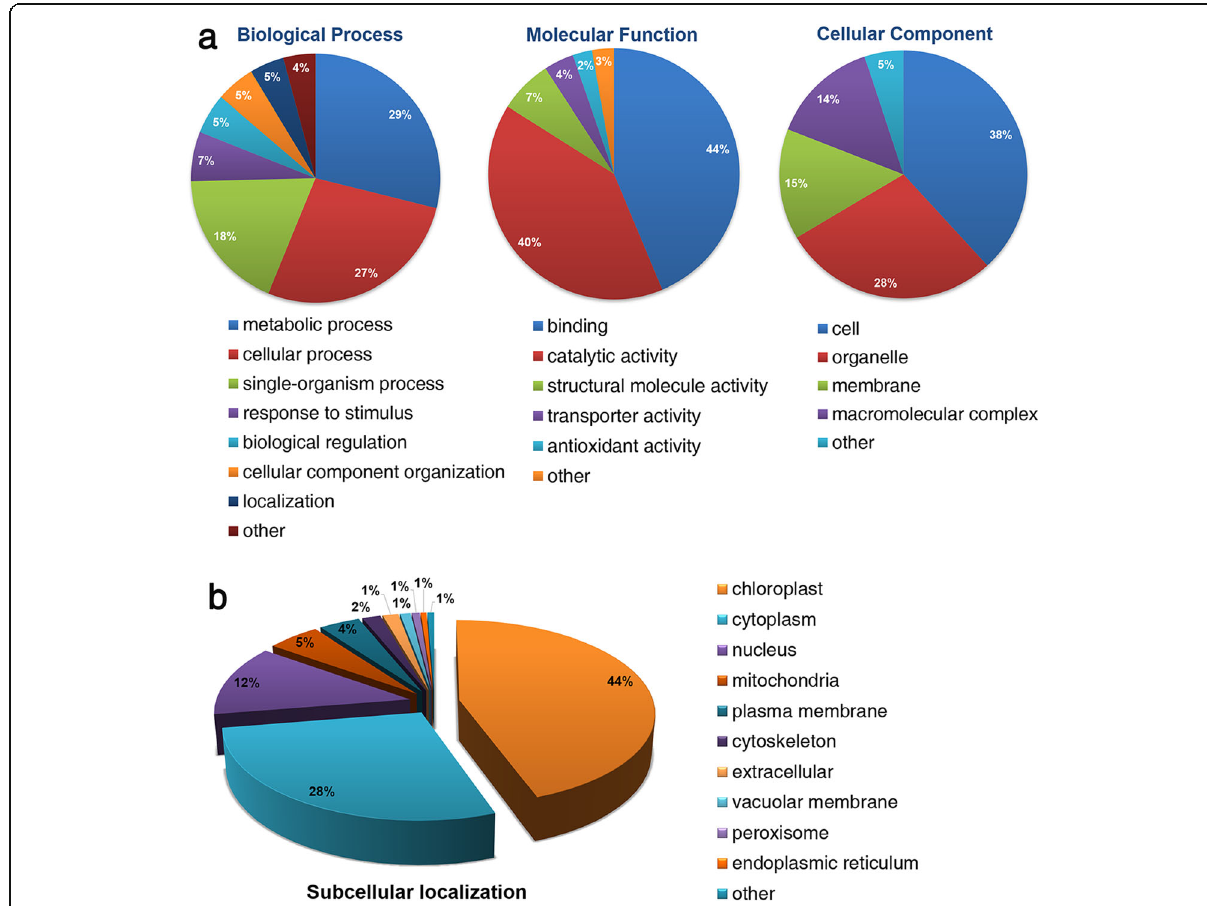
Fig. 3 GO functional classification and subcellular localization of Khib modified proteins. a Classification of Khib proteins based on biological process, molecular function, and cellular component. b Subcellular localization of Khib